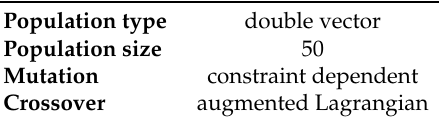
Table 5. Configuration of Differential Evolution algorithm in the blade optimization